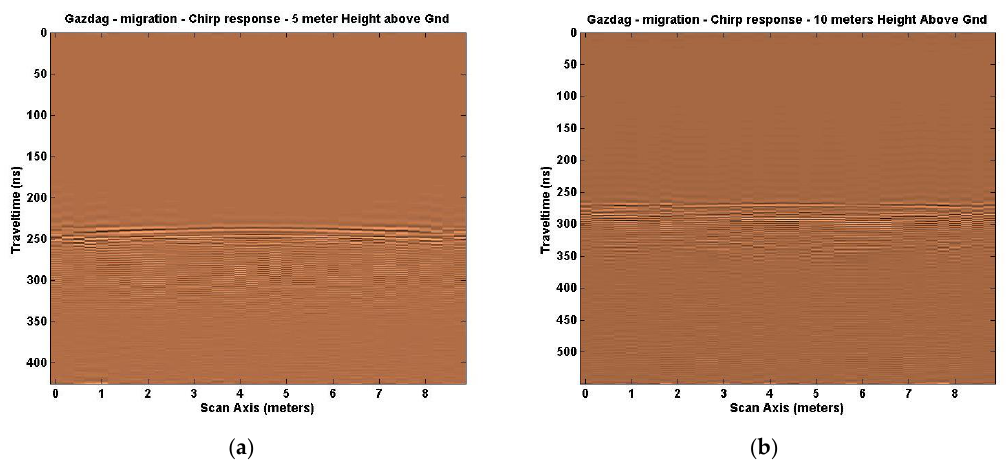
Figure 9. ( a ) Gazdag [17] translated output response of SA1 for 5-m height chirp excitation. ( b ) Gazdag [17] translated output response of SA1 for 10-m height chirp excitation.